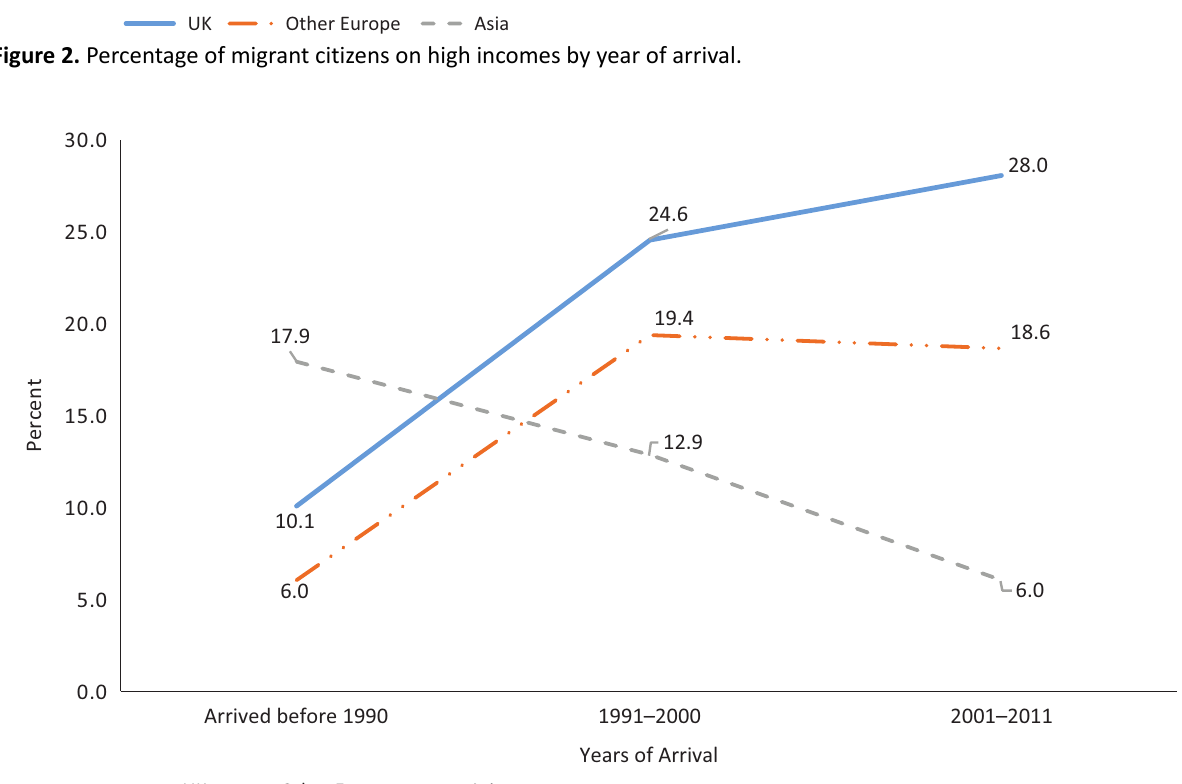
Figure 2. Percentage of migrant citizens on high incomes by year of arrival.